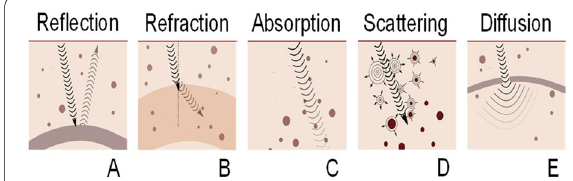
echo. c The B-mode image corresponds to the tissue